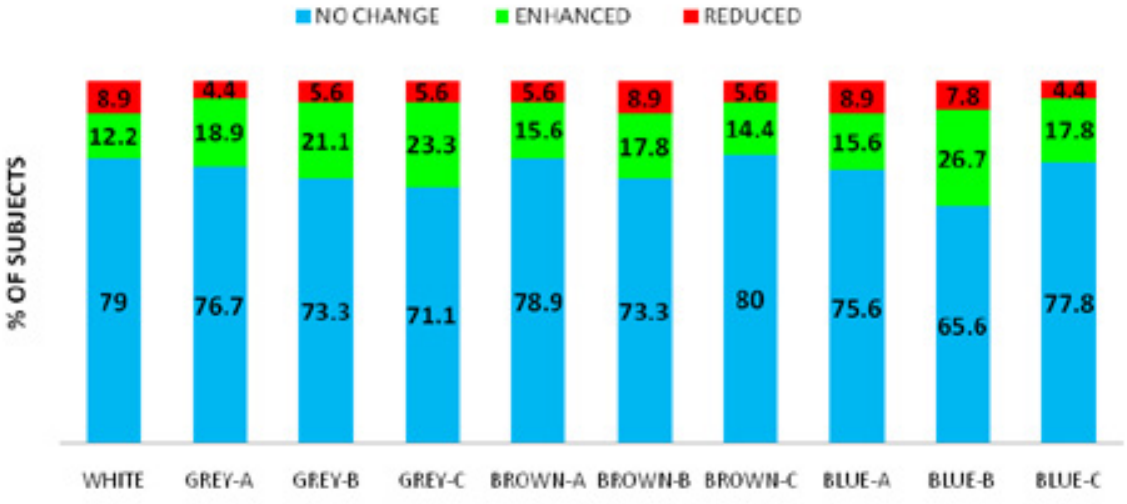
Figure 6: Effect of the varying grades of tinted spectacle lenses on colour